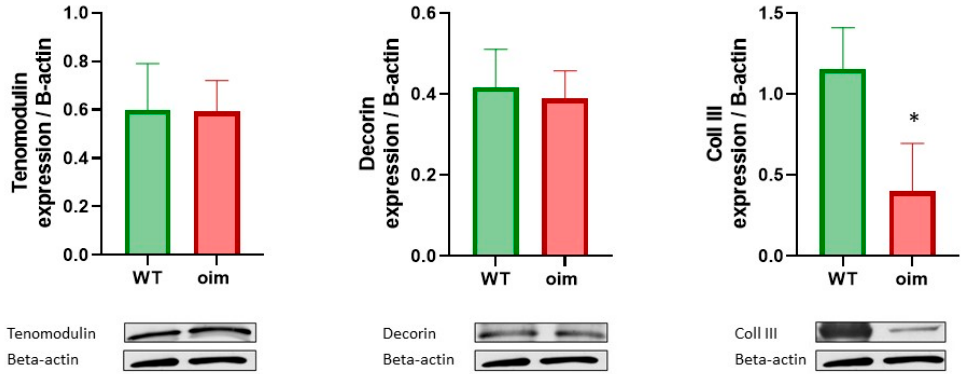
Figure 5. Western blot in tail tendon; the expressions of tenomodulin, decorin and collagen type III are normalized to beta-actin; n = 6 for both groups; * p < 0.05.